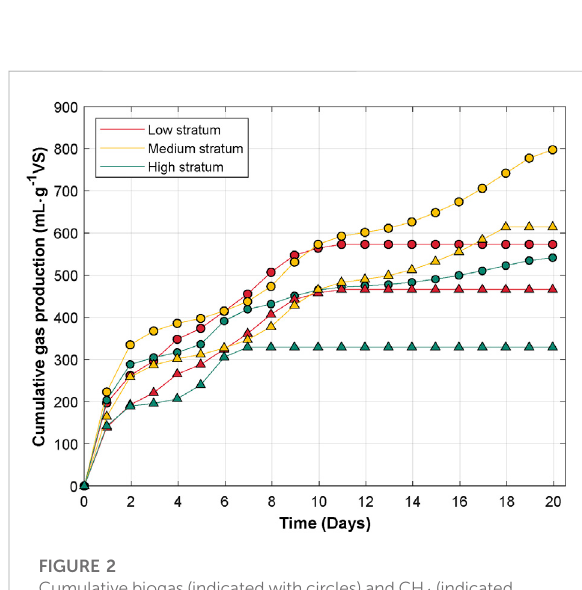
FIGURE 2 Cumulativebiogas (indicated with circles) and CH 4 (indicated with triangles) production from anaerobically digested (37 ° C, 108 rpm, S/I: 0.33) OFMSW samples of low, medium, and high socioeconomic